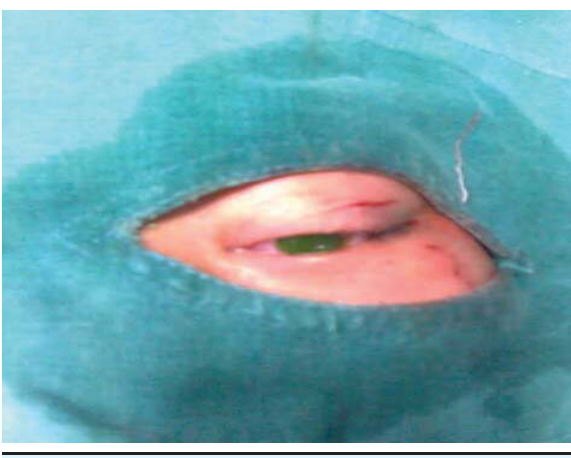
Figure 2. Post-operative photograph at three months